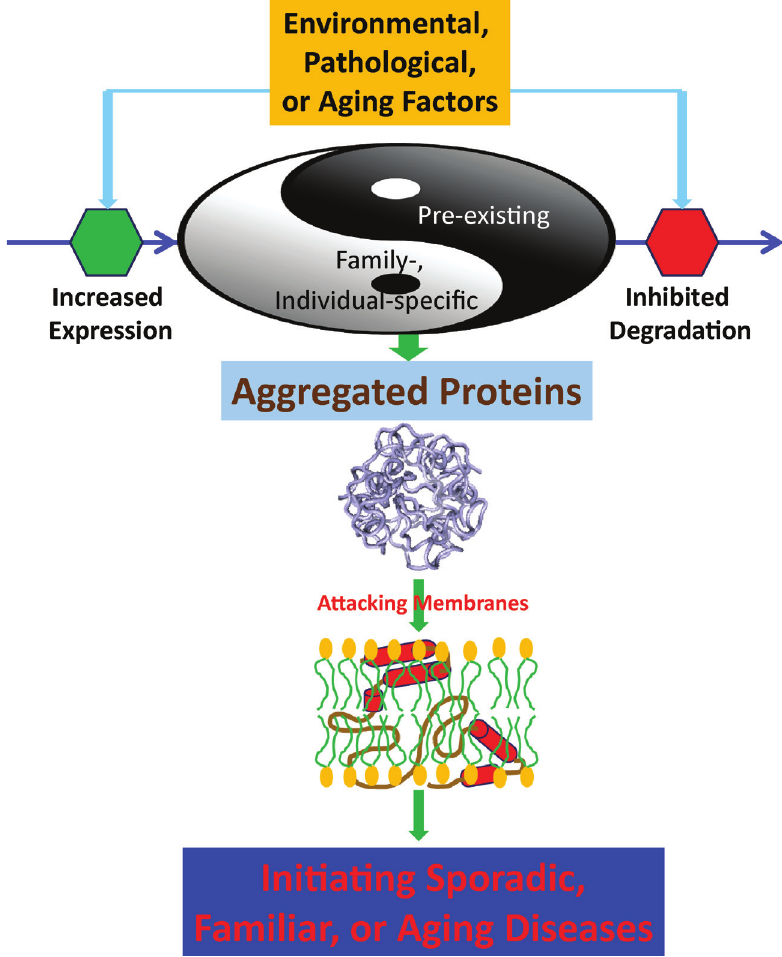
Figure 7. The model for aggregated proteins to initiate sporadic, familiar and aging diseases by commonly attacking membranes. The human genomes appear to contain many pre-existing aggregated proteins like VAPB3. On the other hand, some family members or individuals carry additional genetic mutants like the P56S-VAPB which are insoluble in buffers. Under some environmental, pathological or/ and aging conditions, these proteins might be overexpressed, or/and their degradation gets inhibited. As a consequence, the proteins will accumulate and attack membranes to initiate various diseases including